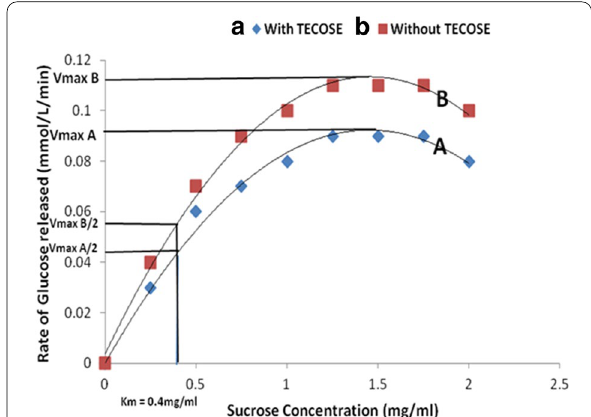
Fig. 6 Rate of glucose released from sucrose by α-glucosidase in the presence and absence of TECOSE